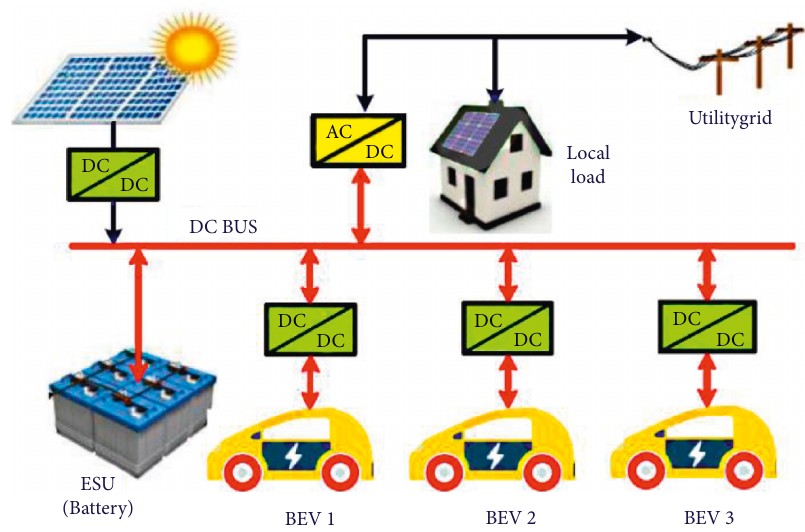
Figure 26: Multiport charging station architecture.